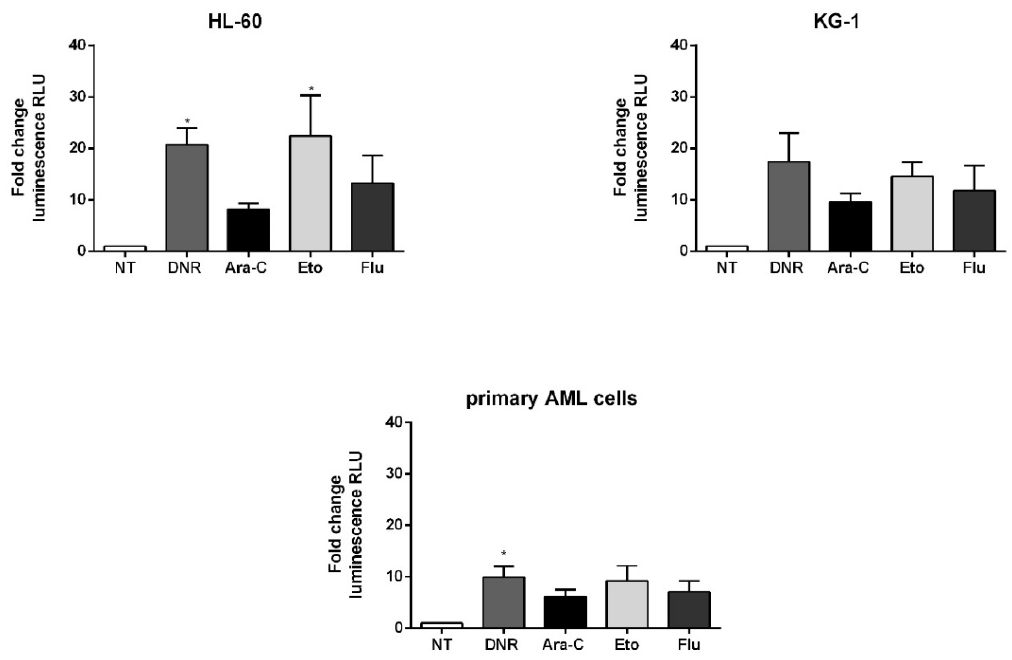
Figure 5. Luminescence analysis of adenosine triphosphate (ATP) release from HL-60, KG-1 and primary AML cells treated with chemotherapy. Indirect measurement of ATP by quantification of emitted bioluminescence in supernatants of HL-60, KG-1 and primary AML cells treated or not (no treatment; NT) with daunorubicin (DNR) (500 ng/mL), cytarabine (Ara-C) (20 µg/mL), etoposide (Eto) (20 µg/mL) and Fludarabine (Flu) (70 µg/mL) for 24 h, was expressed as fold change. The values of un-treated cells were equal to 1. The values are represented as mean ± SEM of 5/3/3 independent experiments for HL-60/KG-1/primary AML cells, respectively. * p < 0.05; compared to un-treated cells.